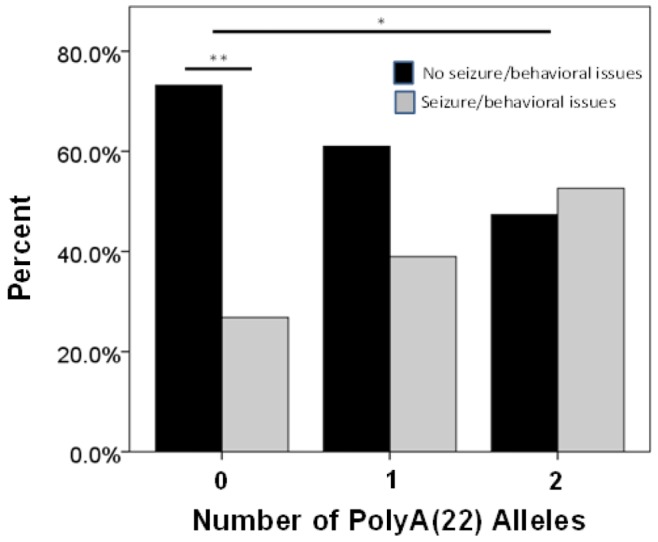
PolyA alleles and owner-reported behavioral changes.General behavior changes: Distribution for number of PolyA(22) alleles (0: Malinois with no PolyA(22) alleles; 1: Malinois with one PolyA(22) allele; 2: Malinois homozygous for PolyA(22)) for owners reporting seizures or unpredictable behavioral changes including dogs’ eyes “glazing over”, dogs’ lack of response to environmental stimuli, and loss of behavioral inhibition (gray bars) or no seizure or behavioral issues (black bars). *: p<0.05; **: p<0.01.